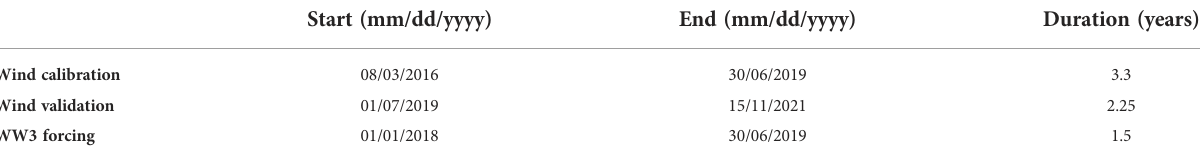
TABLE 2 Duration of calibration, validation and WW3 forcing periods, using scatterometer and IFS-ECMWF neutral wind